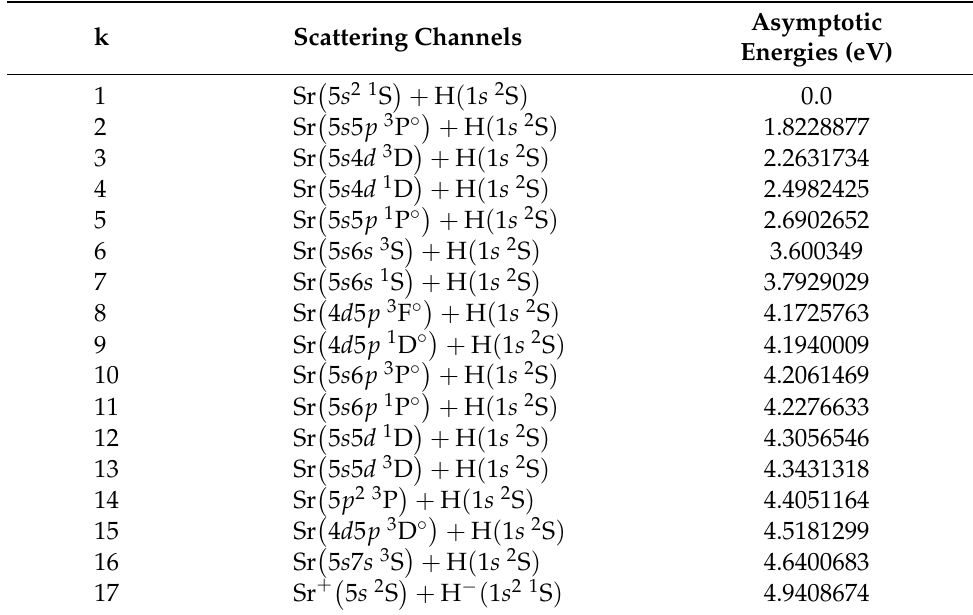
Table A2. SrH (k 2 Σ + ) molecular states, the corresponding scattering channels, their asymptotic energies with respect to the ground-state level (taken from NIST